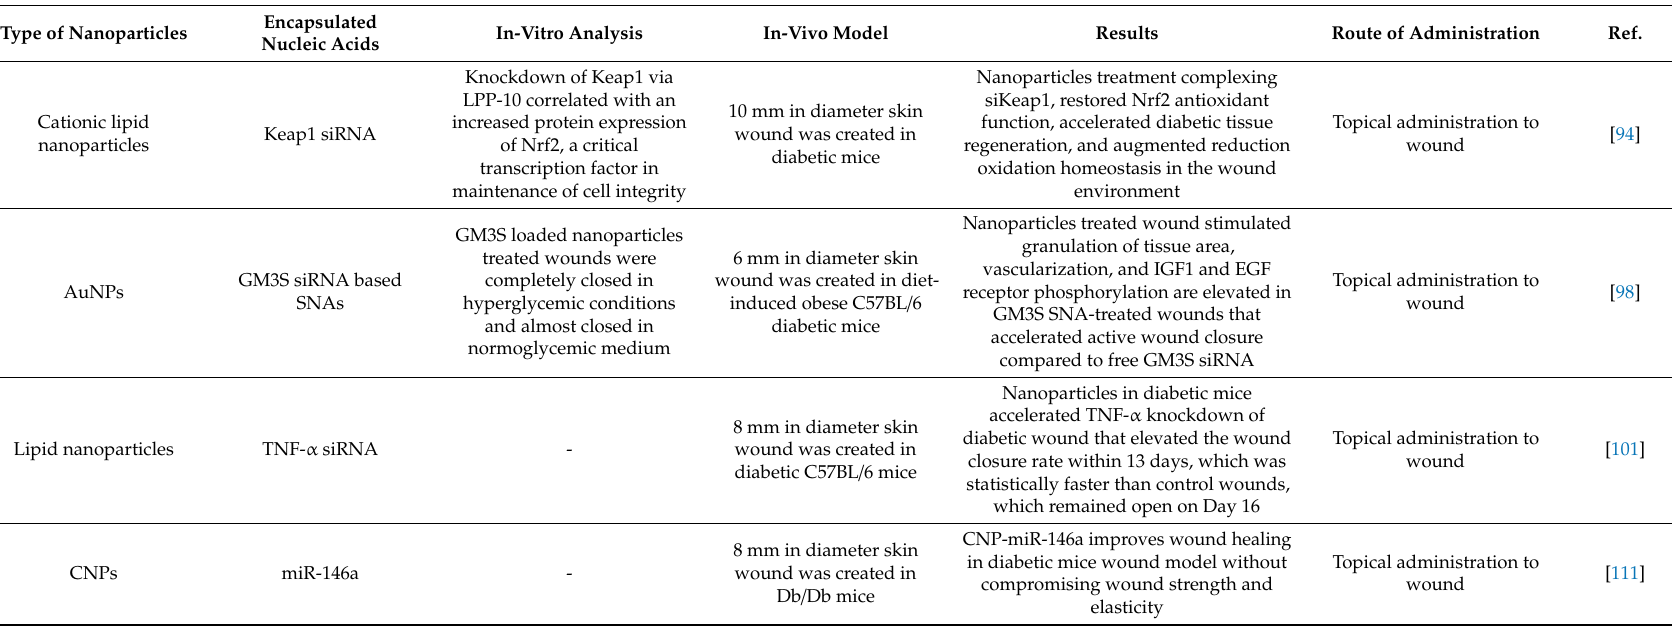
Table 2. Nanoparticles-based therapeutics encapsulated with nucleic acids for diabetic wound